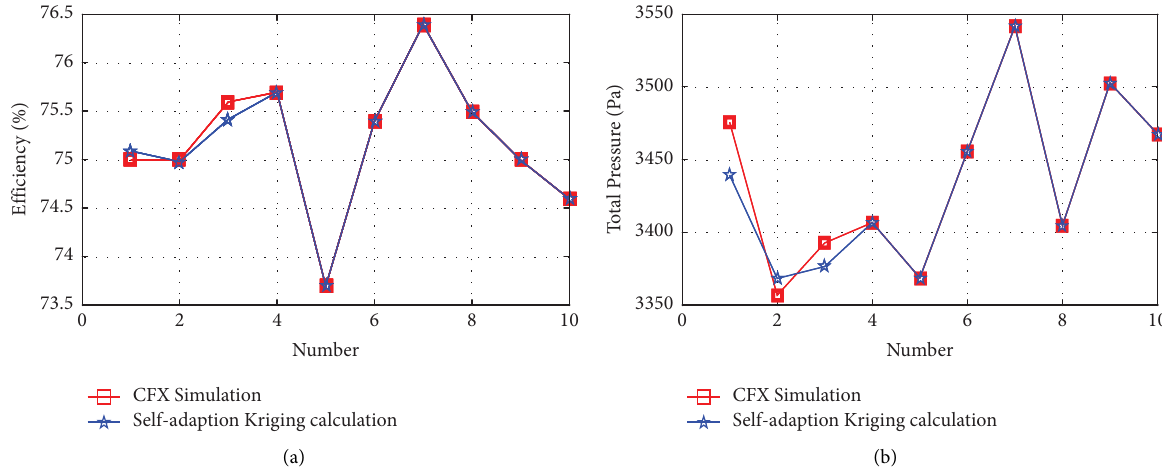
Figure 8: Te output response value calculated by CFX simulation and self-adaption Kriging method: (a) efciency and (b) total pressure.